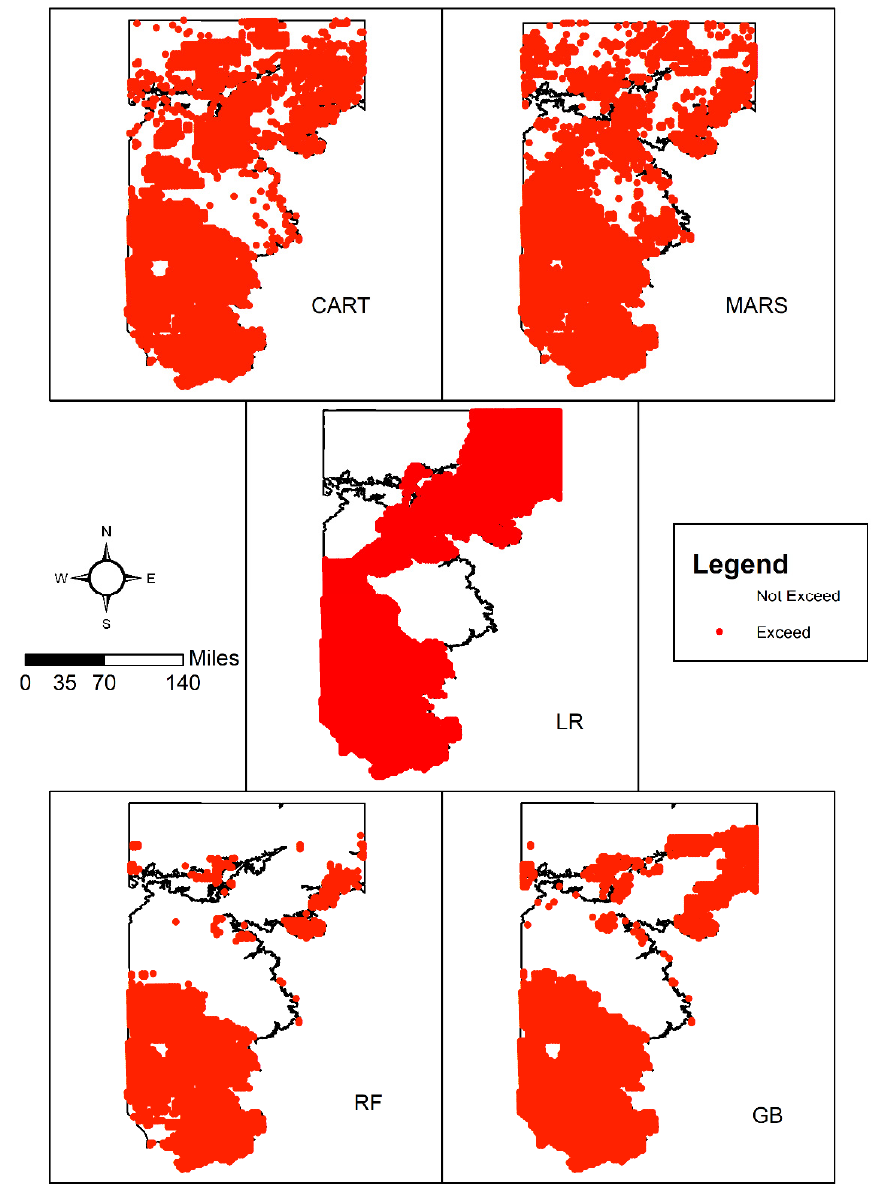
Figure 10. Prediction of Nitrate Exceedance across the Study Area by Di ff erent